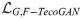
Evaluation results using the LPIPS metric for MRMNet and TecoGAN-G on four different data sets.The loss function used is LG,F−TecoGAN.